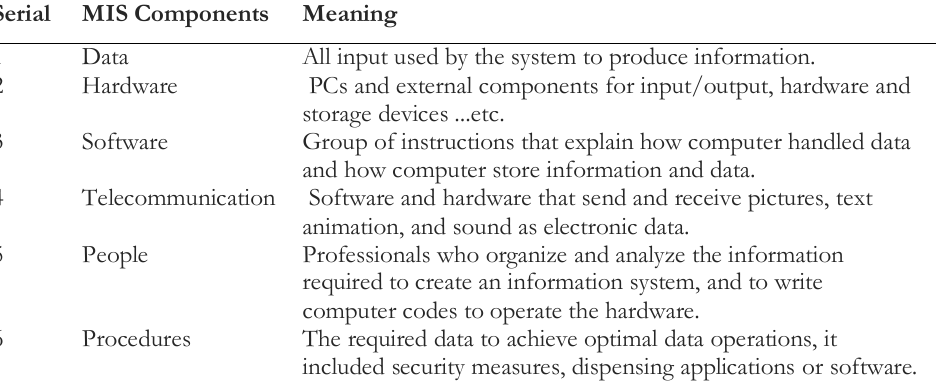
Table 5. Management information system in each component.